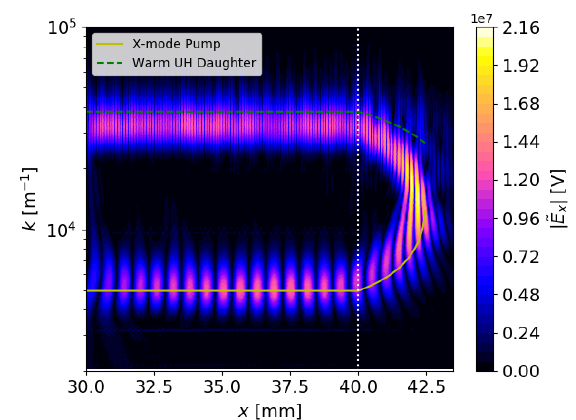
(a) Spectrum near the pump frequency.